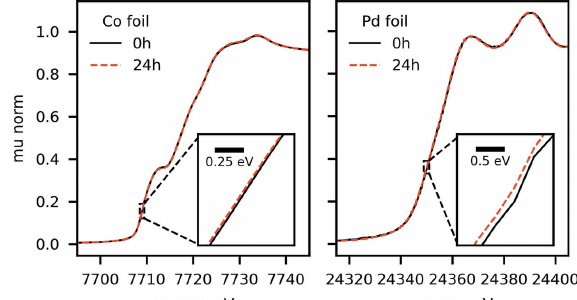
Figure 10 Demonstration of the long-term stability of the energy calibration at ISS at low and high energies. (Left) Comparison of the spectra recorded on Co foil over the span of 24 h. The inset zooms on the data around the edge region where the derivative of the absorption coefficient is at its maximum. The horizontal bar shows the energy scale of the inset. (Right) Comparison of the spectra recorded on Pd foil with a time difference of 24 h. The inset focuses on the edge region of Pd as in the left